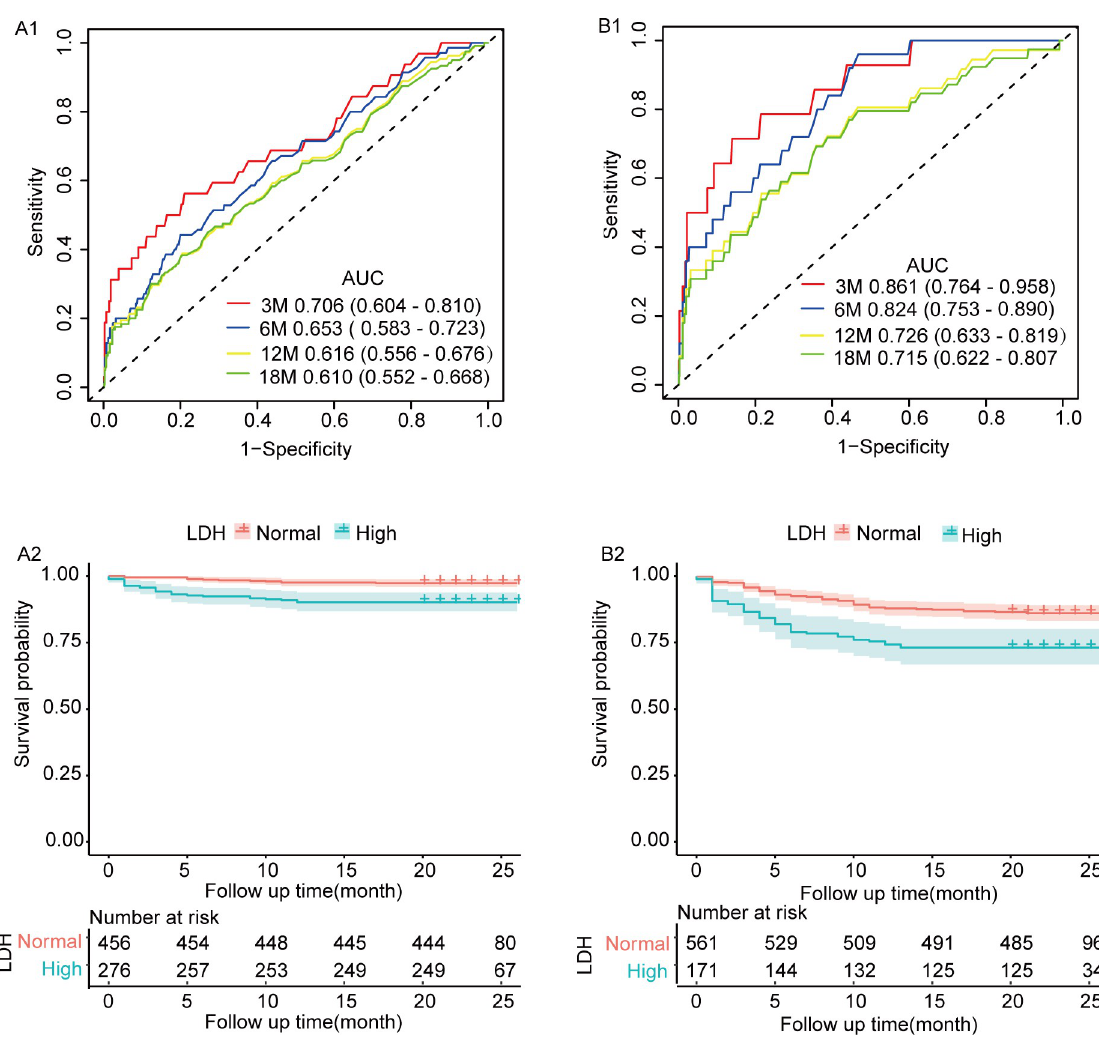
Fig 5. ROC curves and KM curves of LDH for prognosis and all-cause death in patients with AIS. A. ROC curves and KM curves of LDH for prognosis in patients with AIS; B. ROC curves and KM curves of LDH for all-cause death in patients with AIS.